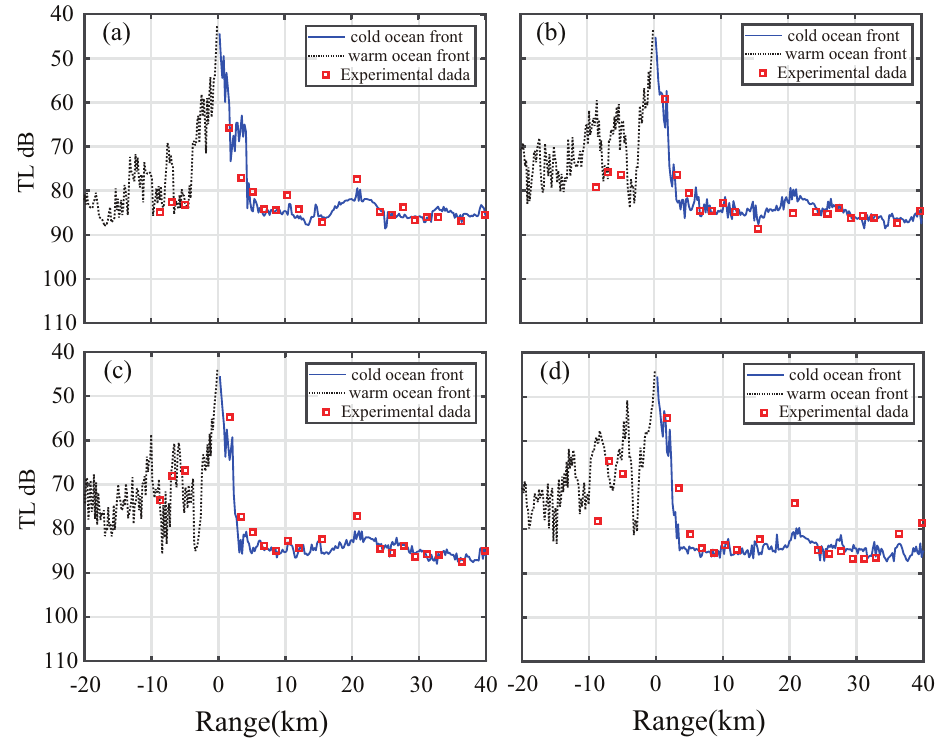
Figure 15. Transmission Loss in cold side (blue dotted line), warm side (black line) and experimental